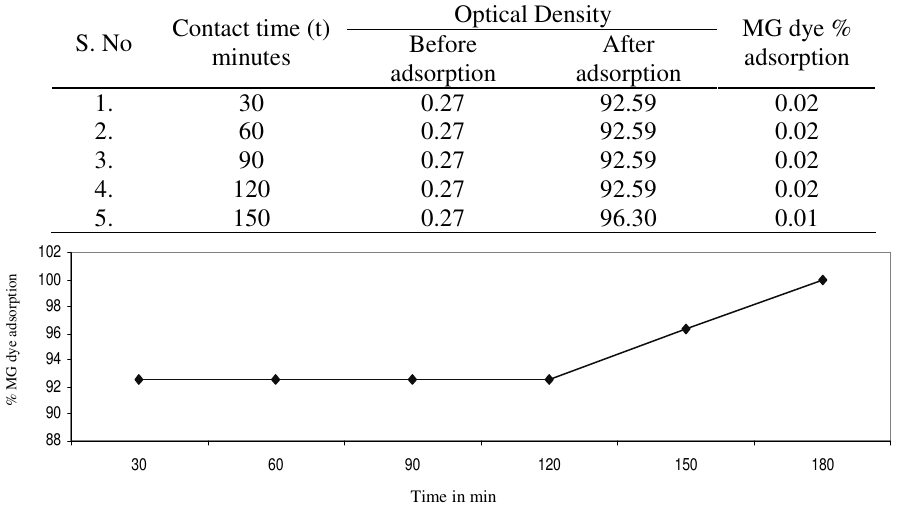
Table 3. Effect of contact time on removal of MG dye (15 mg/L)